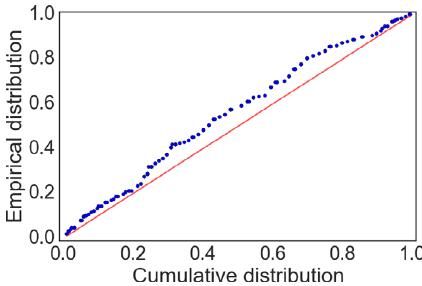
Fig. 6. Quantile – quantile plot of the empirical distribution of p - values (dotted) vs. a uniform distribution (solid line) for rand( ) pseudorandom number generator from C programming language.